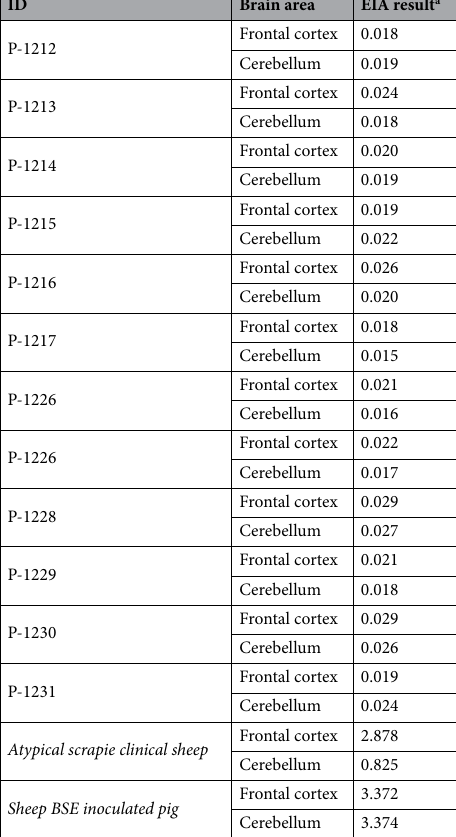
Table 2. Enzyme immunoassay test results for atypical scrapie inoculated pigs. a EIA test was performed using a negative cut off value of 0.14 absorbance units.